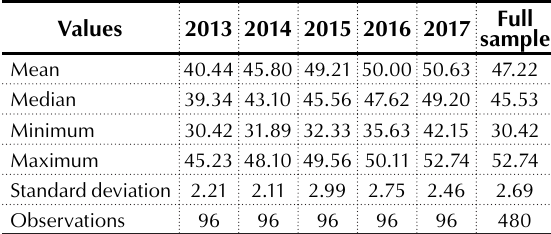
Table 1. Descriptive statistics of overall CGI